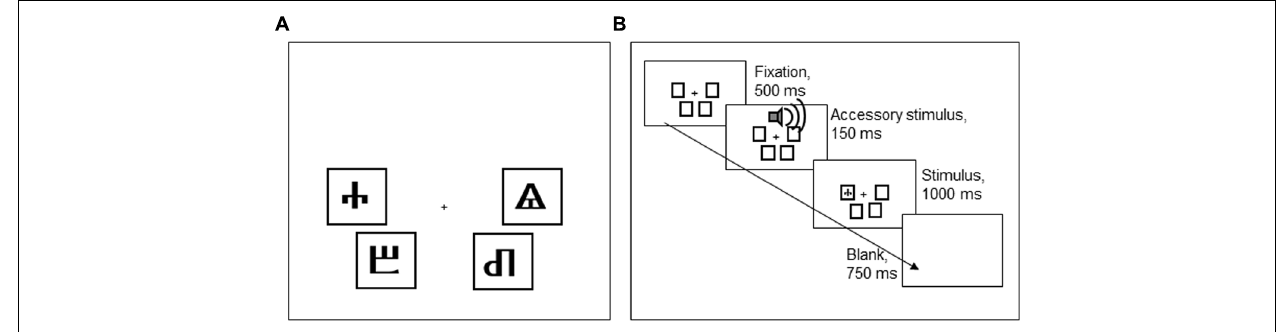
FIGURE 5 | (A) An overview of the four Glagolitic stimuli and their congruent locations on the screen. (B) Order of task events in Experiment